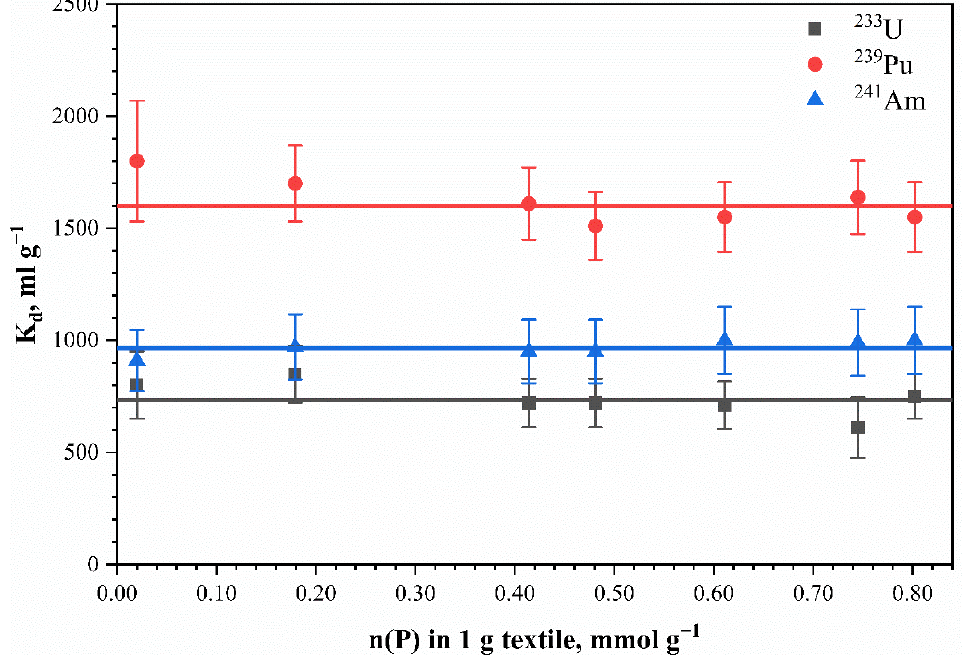
Figure 9. Effects of phosphorus content in mercerized phosphorylated cotton cellulose on the partition coefficient for different radionuclides. Points — experimental data; lines correspond to the partition coefficients. The sorption of 241 Am and 233 U was tested on Moscow tap water; sorption of 239 Pu — with 1.0 mol L – 1 HNO 3 solution.